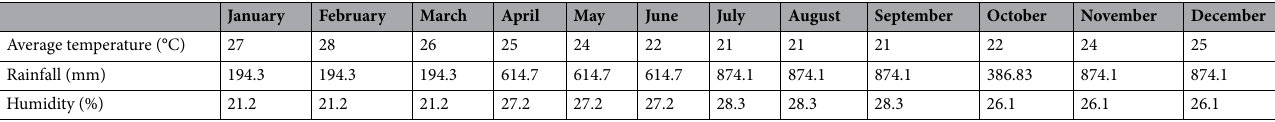
Table 8. Average monthly climatic parameters in Santchou 2020. Source: IRAD